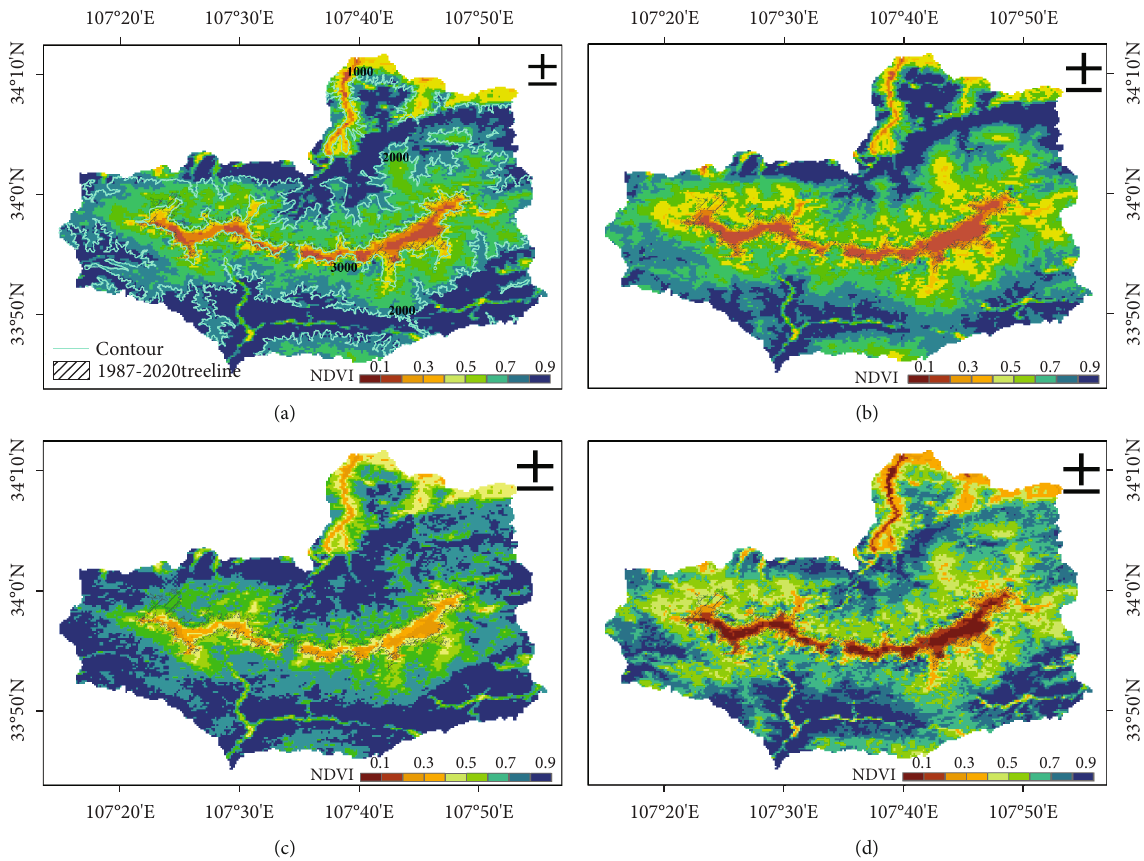
Figure 5: Spatial patterns of the annual and seasonal NDVI for Taibai Mountain from 2000 to 2020: (a) growing season, (b) spring, (c) summer, and (d)